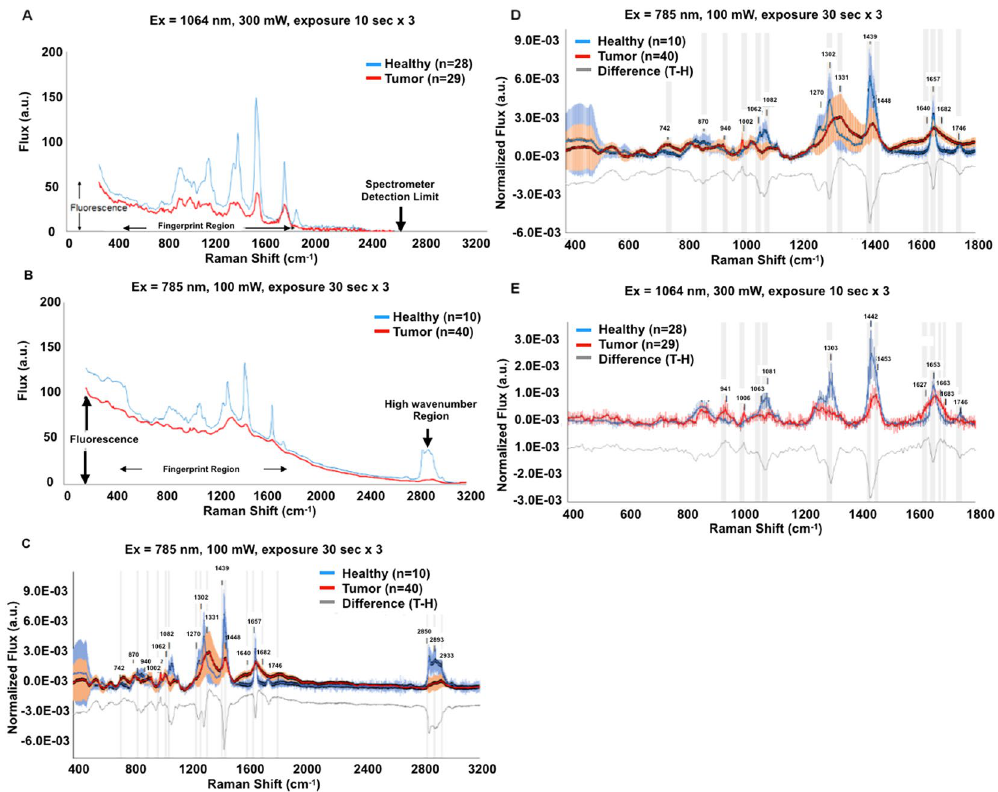
Figure 2. Raw Raman spectra can distinguish healthy and neoplastic tissue. Figure 2A and B compare the fluorescence generated by the two systems. The average raw Raman spectra for healthy and neoplastic tissue samples acquired using 1064 nm ( A ) and 785 nm ( B ) excitation wavelengths are presented exactly as collected without smoothing, fluorescence correction or area normalization. Total laser exposure (defined as laser excitation power x collection time) was 9 × 10 3 mW-seconds for both systems. Raman scattering data are reported in counts per second. The 1064 nm system exhibits less than half the fluorescence ( A ) generated by the 785 nm device ( B ). Fluorescence-corrected, normalized Raman spectra of healthy and neoplastic tissue following 785 nm and 1064 nm excitation appear in ( C , D) and in ( E ), respectively. Full Raman shift spectra provided by the 785 nm device appear in ( C ). The strong Raman signal generated in the high wavenumber region by healthy tissue decreases significantly in the signals generated by malignant tissue. Comparison of tumor and healthy signals reveals a malignant spectral signature in normalized Raman spectra. Raman bands contributing to the signatures are marked graphically by gray bands and listed in Table 1 for both systems. ( C , D ) and ( E ) also exhibit a difference spectrum (gray line), highlighting the disparities between the average healthy and cancerous signatures. Positive deviations from neutral mark increased flux in tumor spectra, while negative deviations denote increased flux in healthy spectra. Due to the limited detector size of the 1064 nm system, the Raman spectrum high wavenumber region (2800–3200 cm − 1 ) can only be acquired using the 785 nm